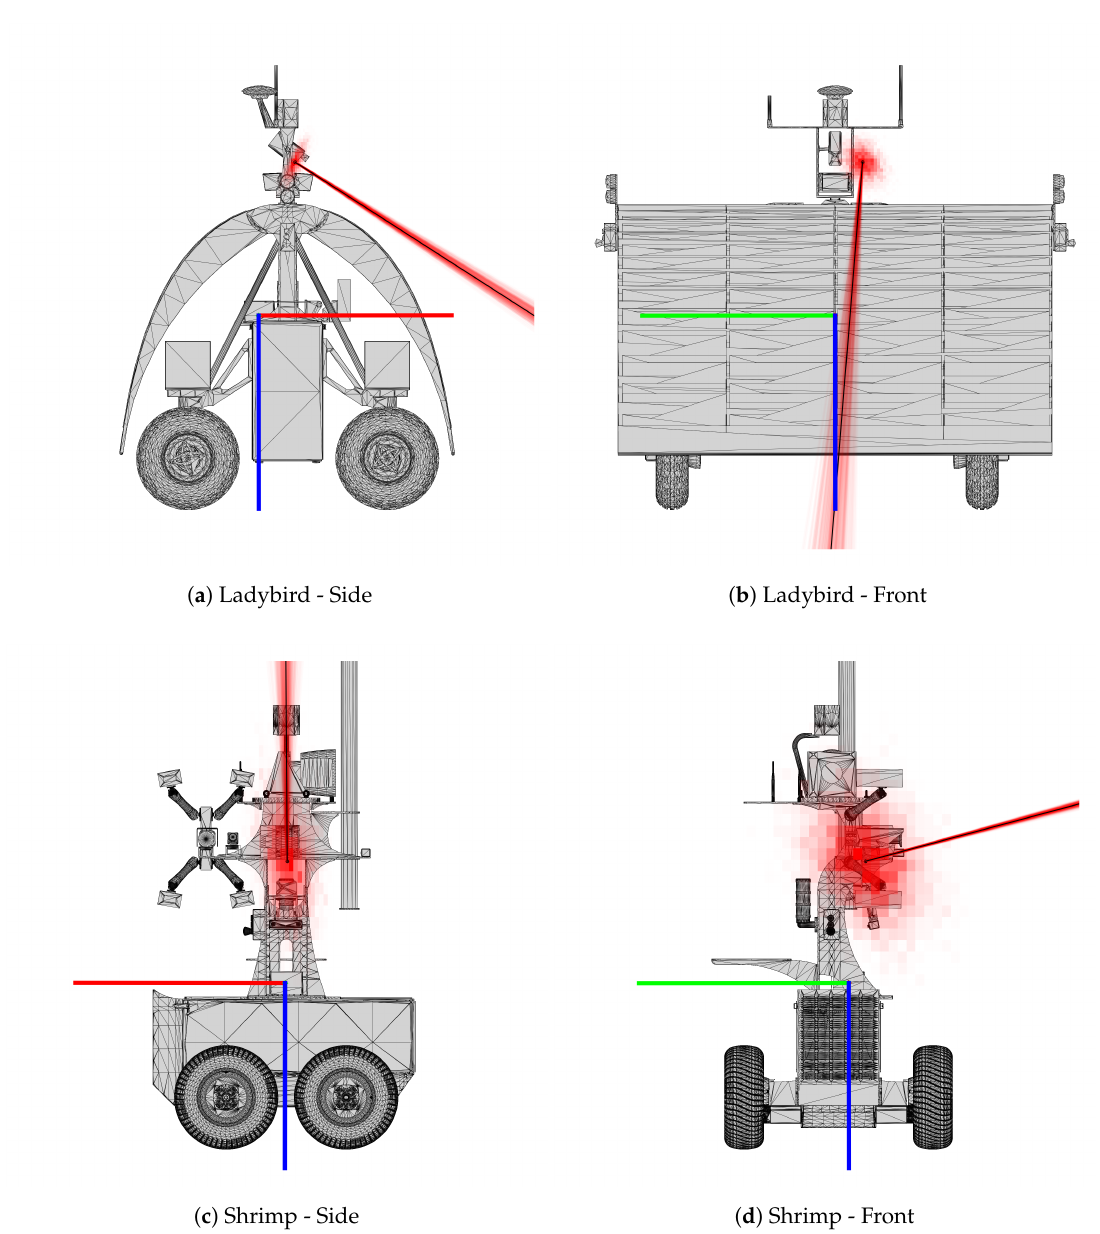
Figure 12. Optimised camera pose and MCMC sample poses for Ladybird ( a , b ) and Shrimp ( c , d ). The optimised pose is shown as an xyz axis with black lines. The MCMC samples are shown as red, green and blue xyz axes, where greater colour intensity corresponds to greater sample density, approximating the marginal likelihood of the poses in the viewing direction. The body (i.e., navigation system) pose is also shown as a red, green and blue xyz